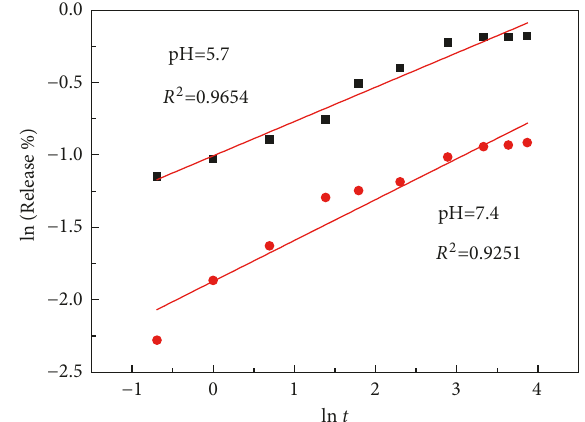
Figure 7: The release curves of DOX-loaded FA-grafted hydroxya- patite in PBS at pH 5.7 and 7.4.